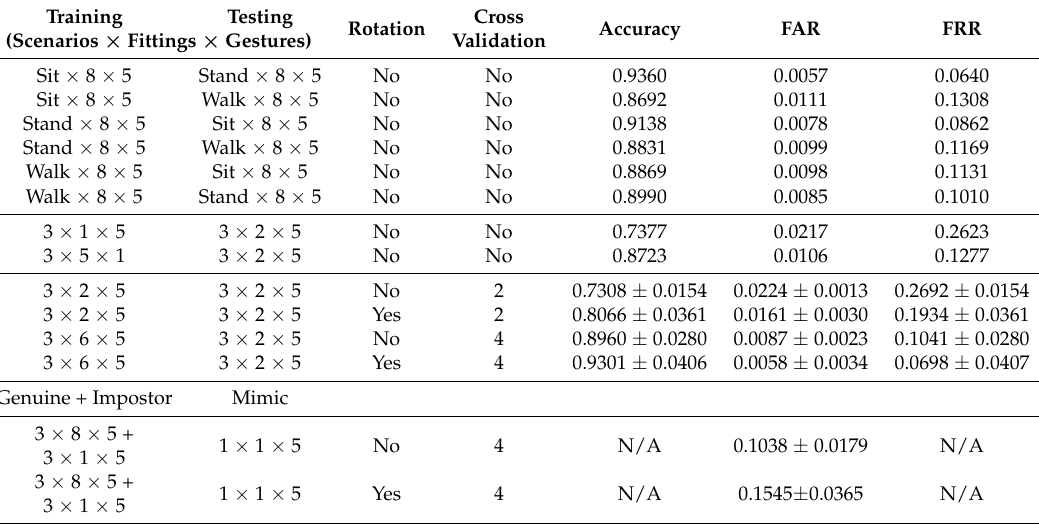
Table 2. Summary of the